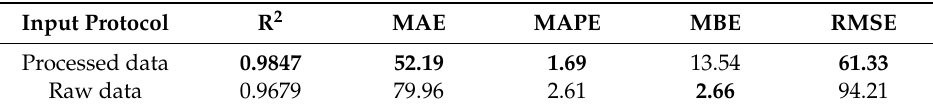
Table 6 compared the results under statistical errors criteria. Table 6. Statistical errors for di ff erent input vectors (raw versus Table 6. Statistical errors for different input vectors (raw versus processed).